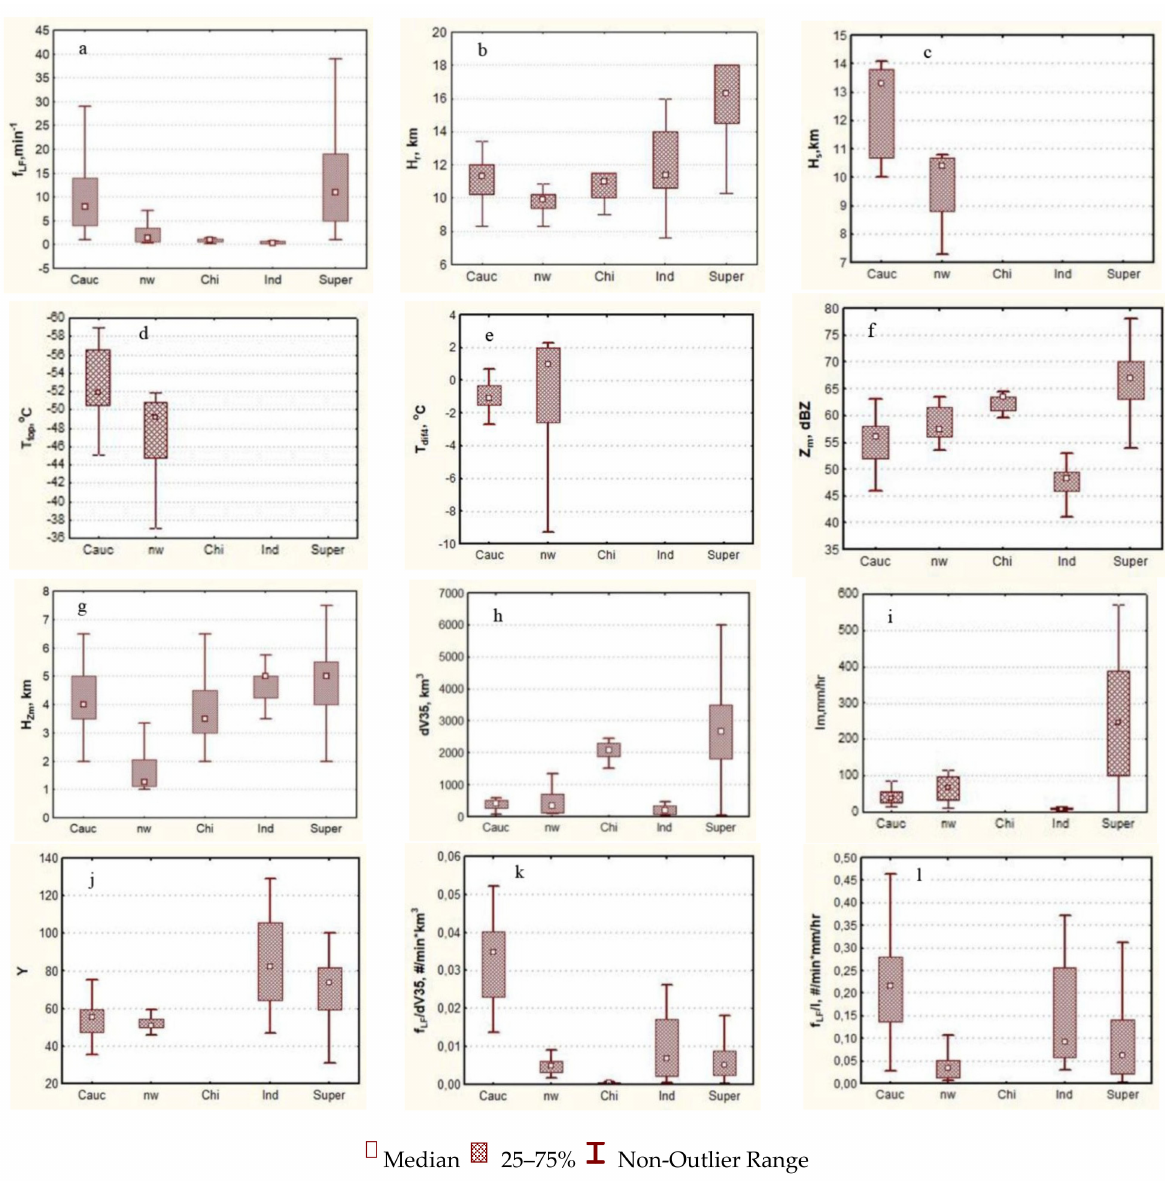
Figure 3. Box-and-whisker diagram of the samples of cloud characteristics during the period of LF lightning strikes. Characteristics: ( a ) the frequency of lightning strikes f LF (min − 1 ); ( b ) the radar cloud top height H r (km); ( c ) the cloud top height retrieved from the SEVERI measurements H s (km); and ( d ) top temperature by SEVERI measurements T top ◦ C; ( e ) difference in the brightness temperature by SEVERI measurements at 6.2 and 10.8 µ m channels T dif4 ( ◦ C); ( f ) the maximum reflectivity Z m (dBZ); ( g ) the Z m height H Zm (km); ( h ) the volume dV35 (km 3 ) above the zero-degree isotherm with the reflectivity higher than reflectivity threshold of 35 dBZ; ( i ) maximum precipitation intensity I m (mm/h); ( j ) thundercloud criteria Y ; ( k ) relationship of lightning frequency to dV35 and I m ( f LF /dV35(min − 1 /km 3 ; and ( l ) f LF / I m (min − 1 /mm/h)). The abscissa axis: north Caucasus (Cauc), northwestern Russia (nw); China (Chi); India (Ind); and supercell Cb observed in the north Caucasus